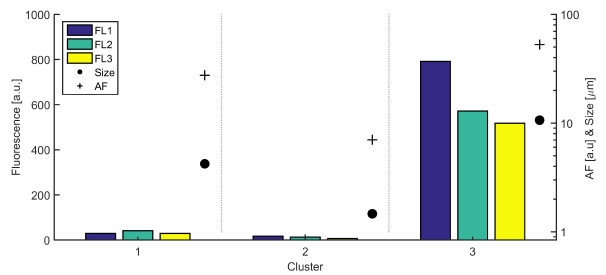
Figure 12. Mean cluster centres for the three cluster solution using Ward linkage and Calinski–Harabasz metric. Clusters contribute 25, 70, and 5% to the fluorescent particle